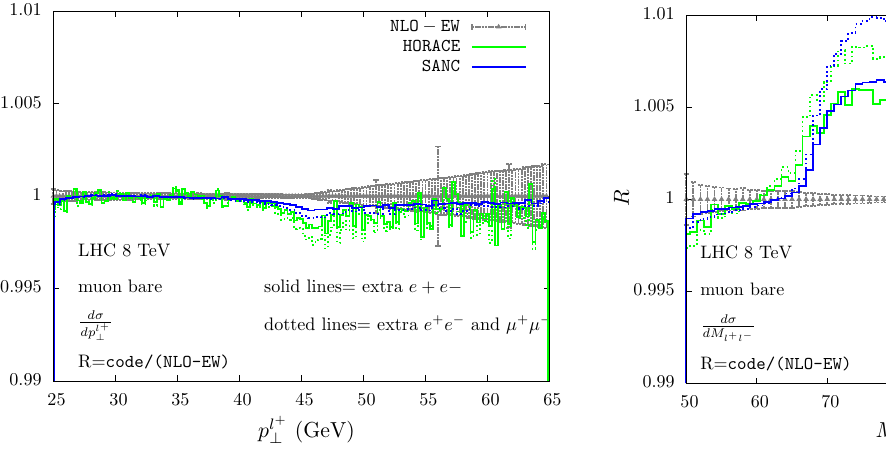
Fig. 33 Relative effect of the emission of an additional light-fermion pair in pp → μ + μ − + X , compared to the NLO EW cross section in the benchmark setup. The solid lines represent the effect of emitting an additional e + e − pair, while the dashed lines account for the possibility